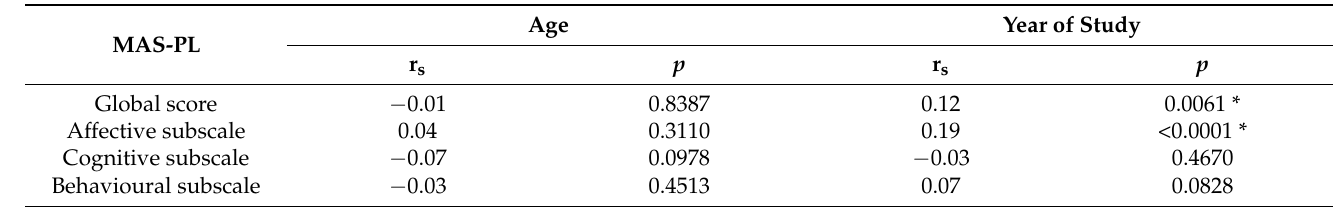
Table 7. Relationships between the results of the MAS-PL scales and the age and year of study of the surveyed students.